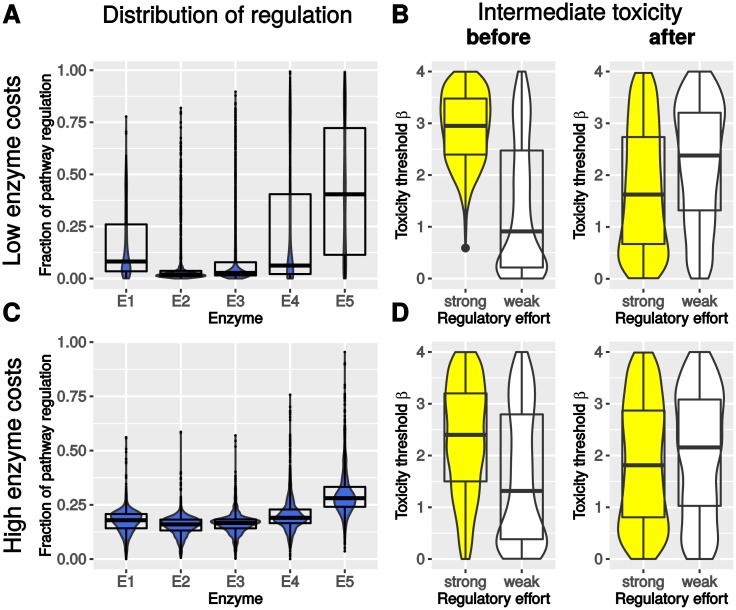
Relationship between regulatory effort and intermediate toxicity for low (A,B) and high enzyme costs (C,D).(A,C) The fraction of regulation is displayed in blue for each enzyme. (B,D) The intermediate toxicity is depicted in yellow (white) for the case of a strongly (weakly) regulated enzyme and the toxicity threshold of intermediates before and after (lower values indicate higher toxicity). All plots show the distribution of values as a combination of violin- and box-plots indicating median and 25–75% percentile.